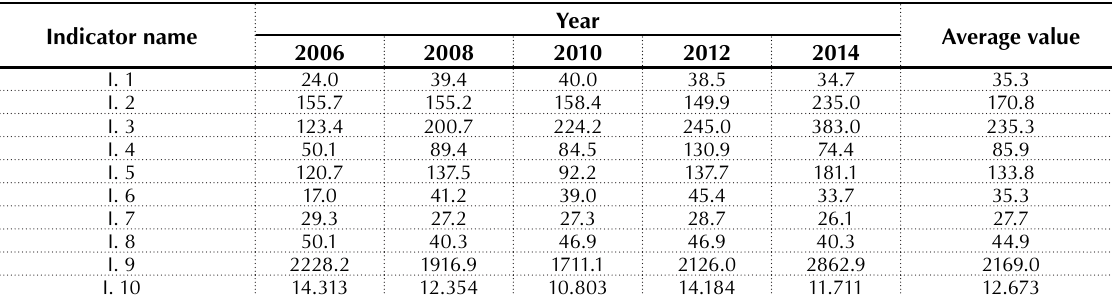
Table 2. The actual values of indicators of innovation activity of light industry companies in the EU